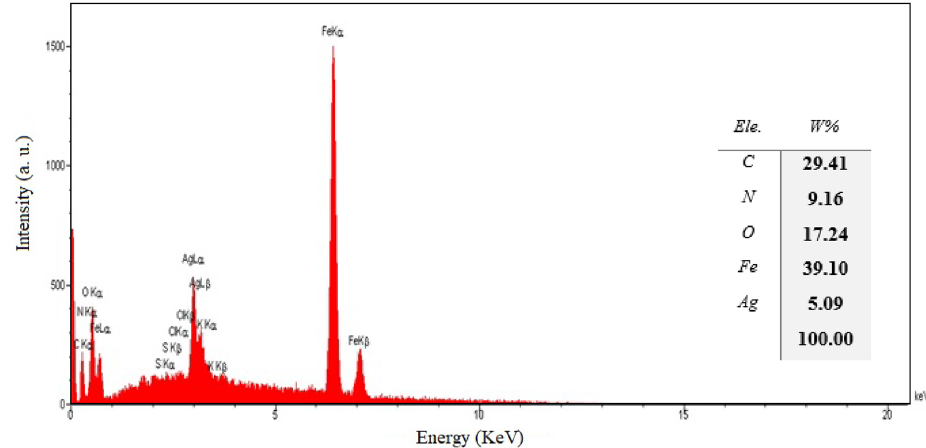
Figure 5. EDS of the biochar/Fe 3 O 4 /PVIm/Ag